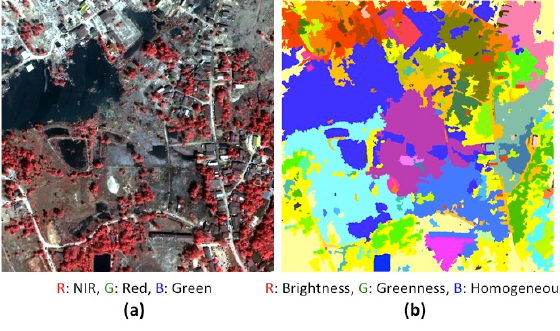
Figure 4. (a) False Colour Composite of original QuickBird image and (b) coarse level